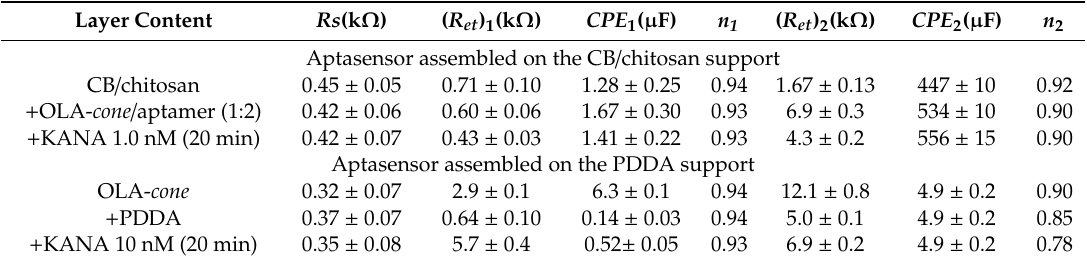
Table 1. The EIS parameters of the GCE covered with OLA- cone / aptamer (1:2 mixture). Mean ± S.D. for the three individual sensors is